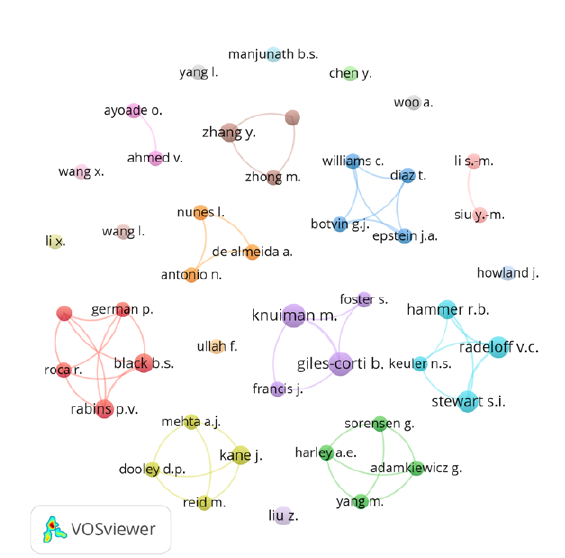
Figure 5. Researchers’ network of collaboration in AI and PM research